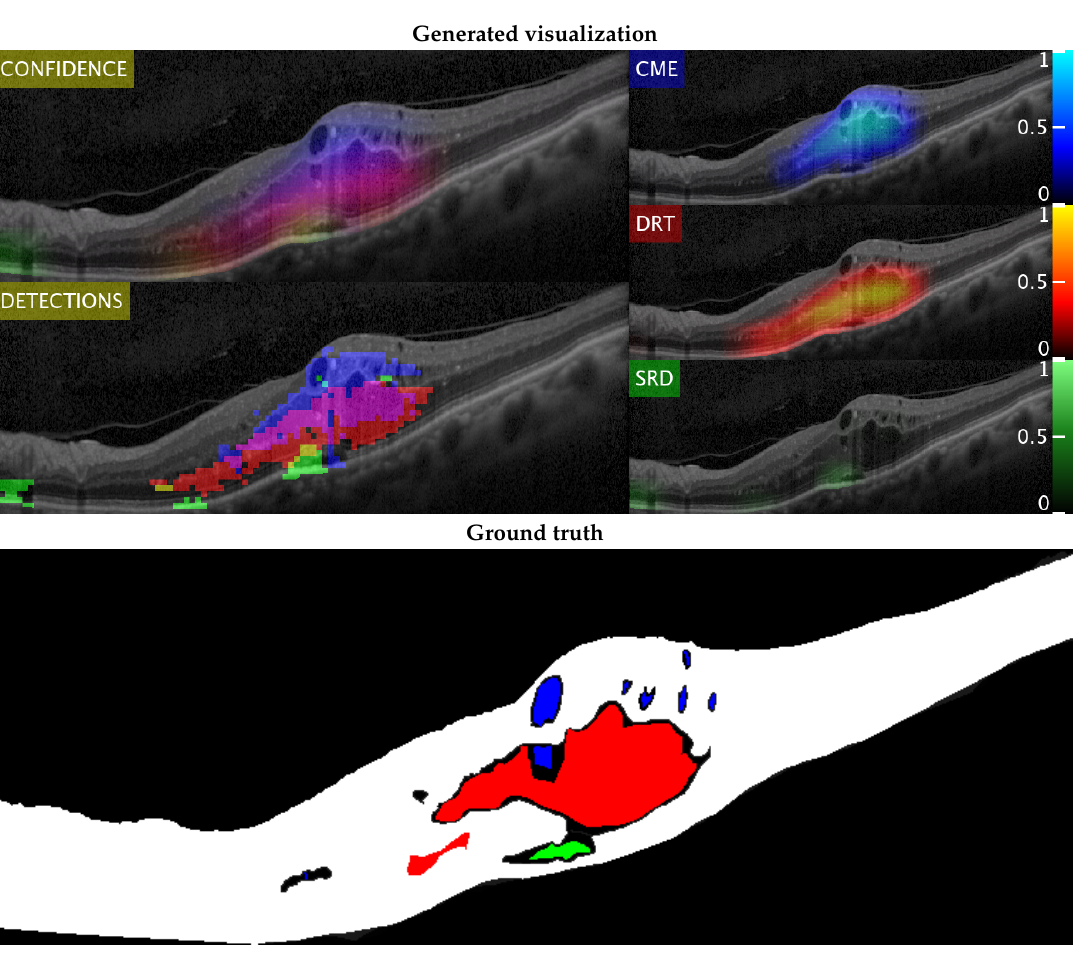
Figure 14. Test visualizations generated using images from the Spectralis